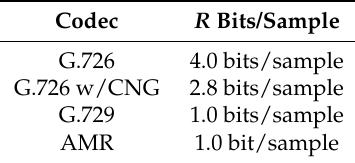
Table 6. Codec rates to achieve PESQ/MOS of 4.0 for “Lathe” [6]. CNG, comfort noise